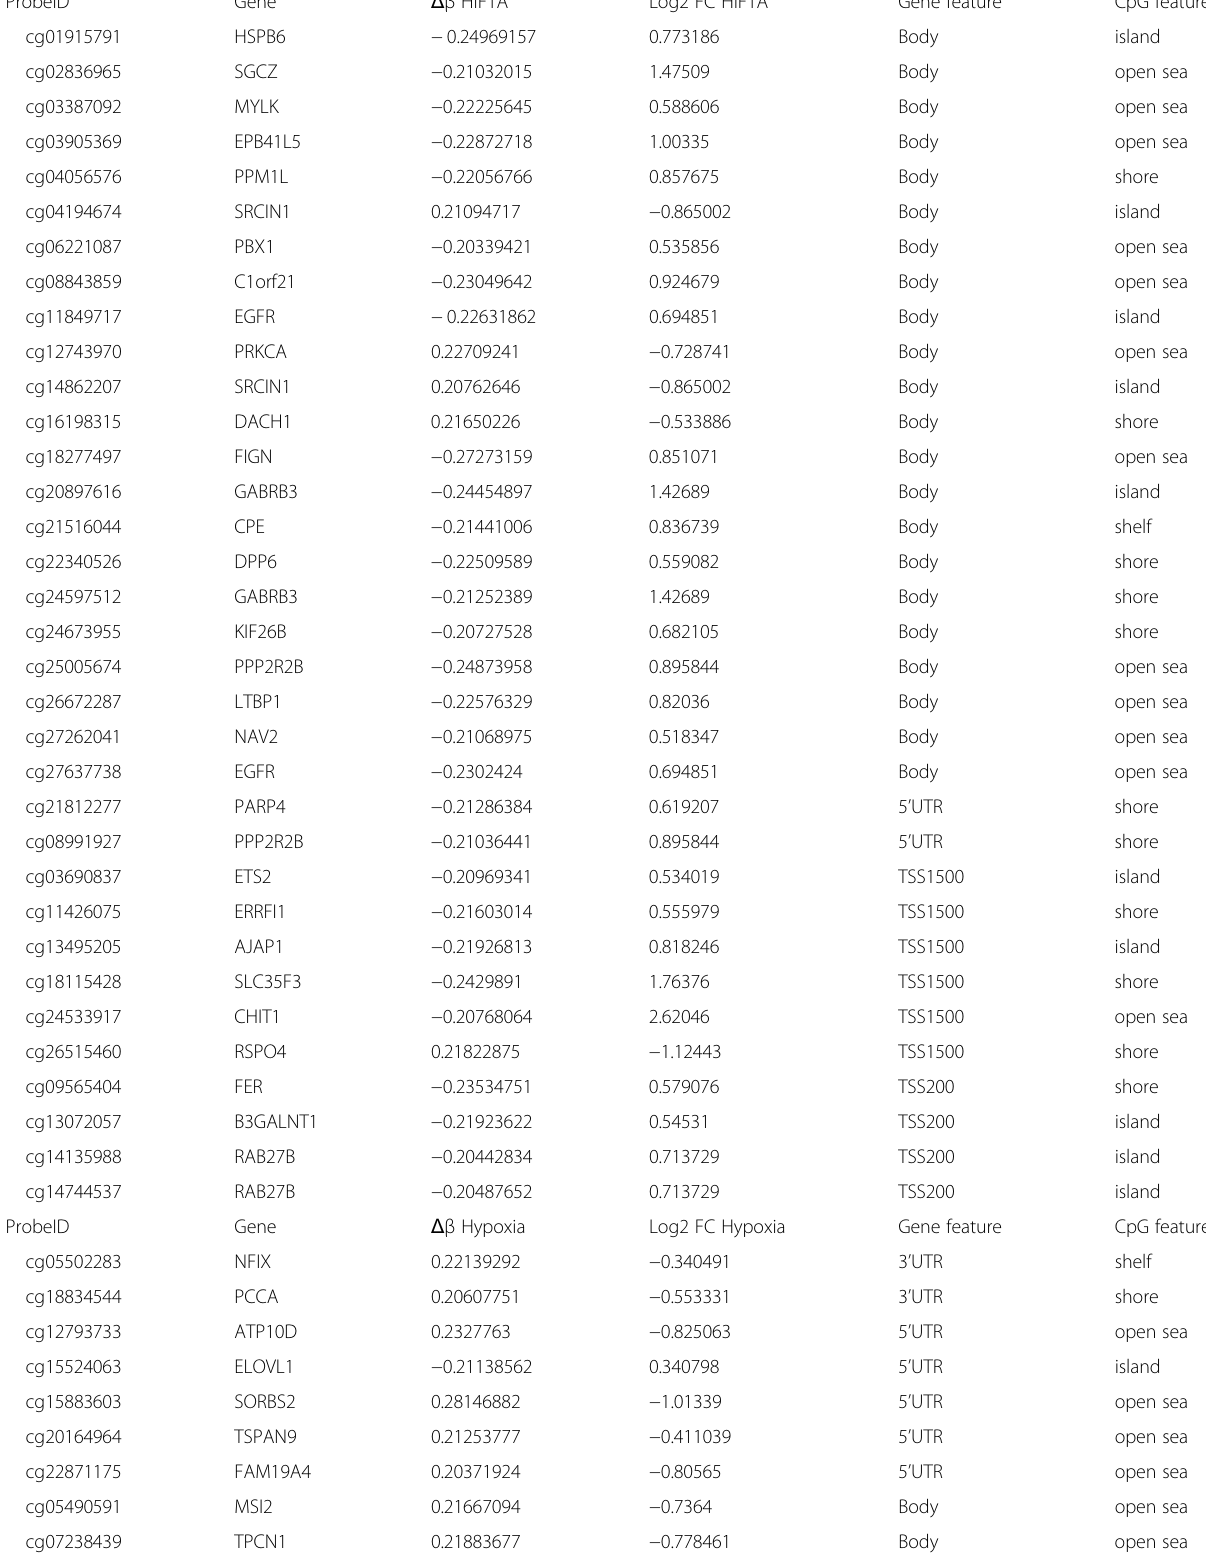
Table 1 Correlation between DNA methylation (Probe ID) and gene expression (Gene) in hypoxia